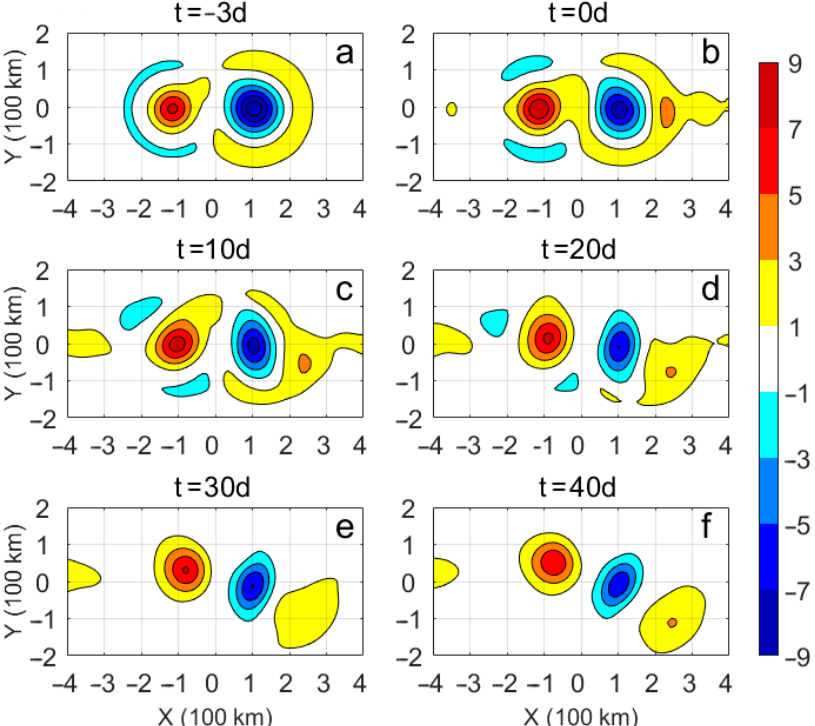
Figure 8. Temporal and spatial evolution in vertically integrated relative vorticity of the model dipole: ( a – f ) are simulated results of the vertically integrated relative vorticity (unit: 10 − 3 m·s − 1 ) at − 3, 0, 10, 20, 30, and 40 days after the TC, respectively. The contour interval is 2 × 10 − 3 m·s − 1 . All the subgraphs are the numerical results filtered with a 1°×1° lowpass spatial filter.